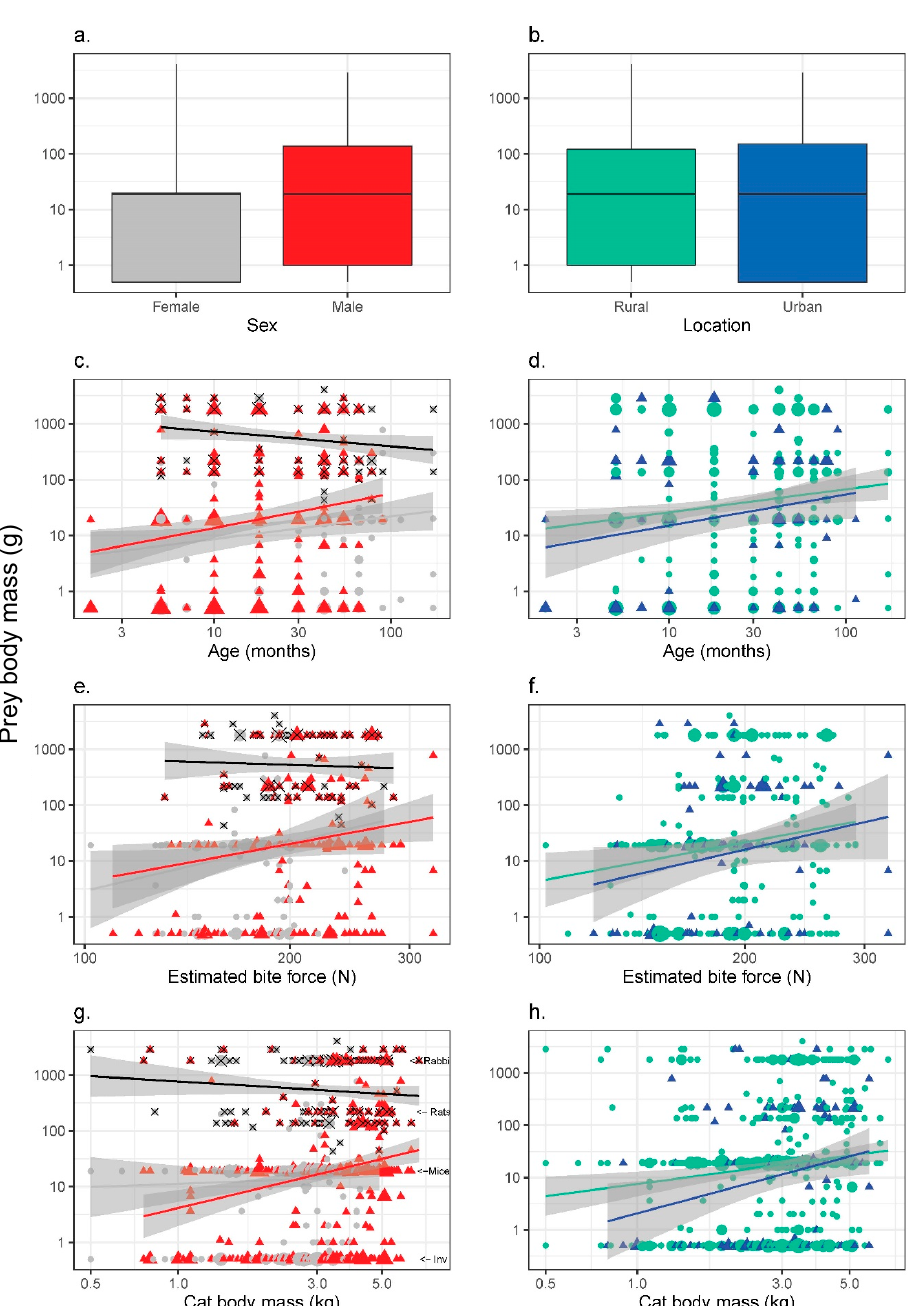
Figure 3. Prey body mass (average body mass for an adult of that species) consumed by cats ( Felis catus ) from southwest Western Australia shown by ( a ) sex (left-hand panel; males = red triangles and females = grey circles) or ( b ) source location (right-hand panel; rural = green circles and urban = blue triangles). Prey body mass shown against age ( c,d ), estimated bite force ( e,f ) and cat body mass ( g,h ). Note Log-transformed axes. Due to overlapping data, symbol sizes represent relative numbers of prey items. Diet was determined for some small cats that we could not determine bite force for (and